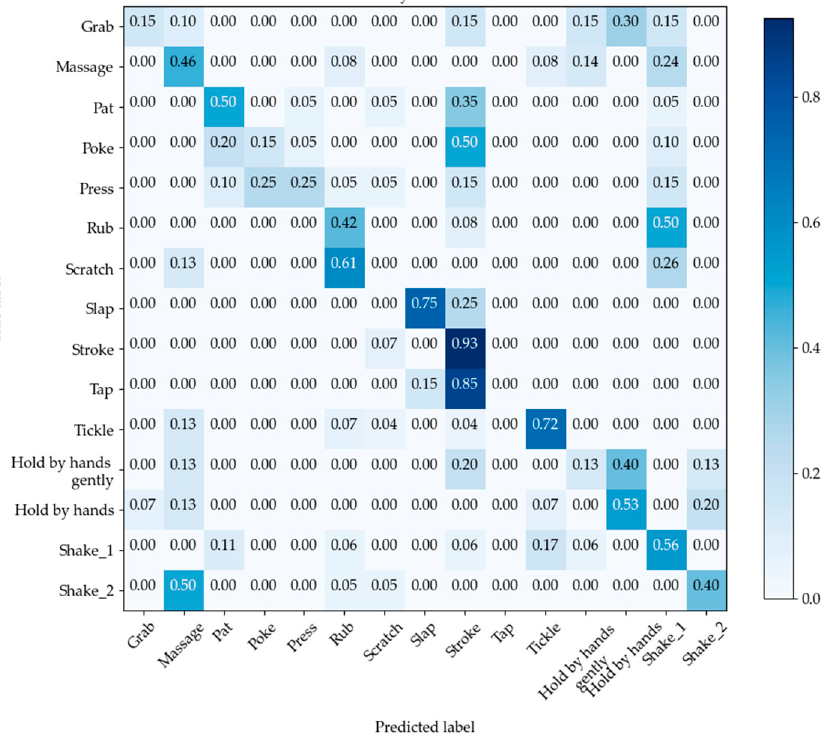
Figure 10. Fifteen touch gestures recognition convolution matrix: ShokacChipTM, average rate: 49%.